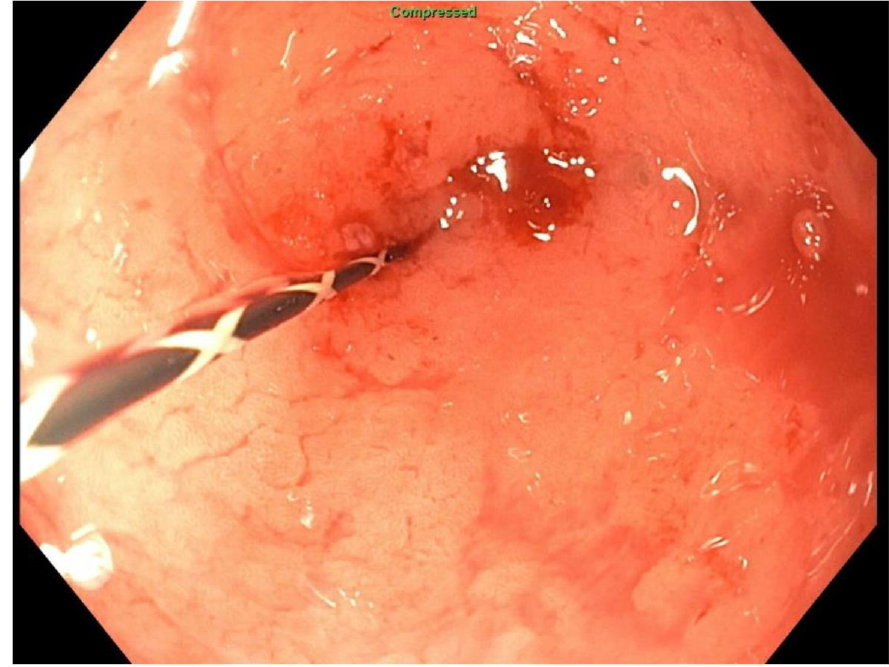
Figure 11. Wire through gastric remnant into orphaned stomach (endoscopic view).